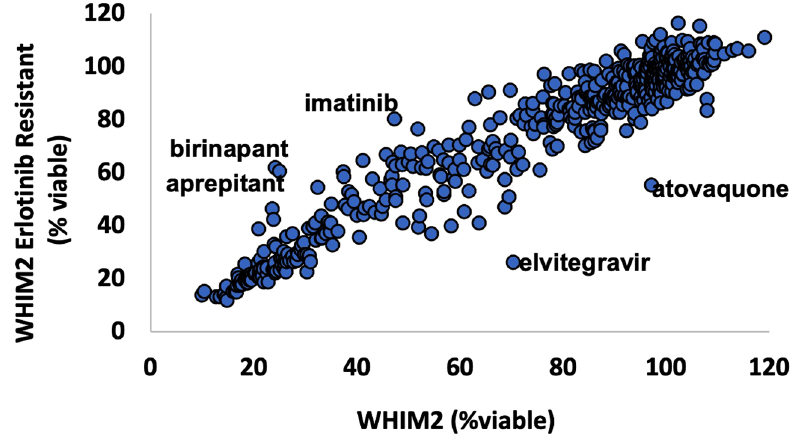
Figure 2. Assessment of 516 FDA-approved and clinically used drugs on parental and erlotinib-resistant WHIM2 PDXs. Tumors were excised from mice, prepped into single cell suspensions, plated in 96-well dishes, and treated with 10 μM of drug. Cell viability was assessed with CellTiter-Glo after 72 h of treatment and normalized to DMSO vehicle control. Parental ( n = 3) and erlotinib-resistant ( n = 3) tumors were treated in